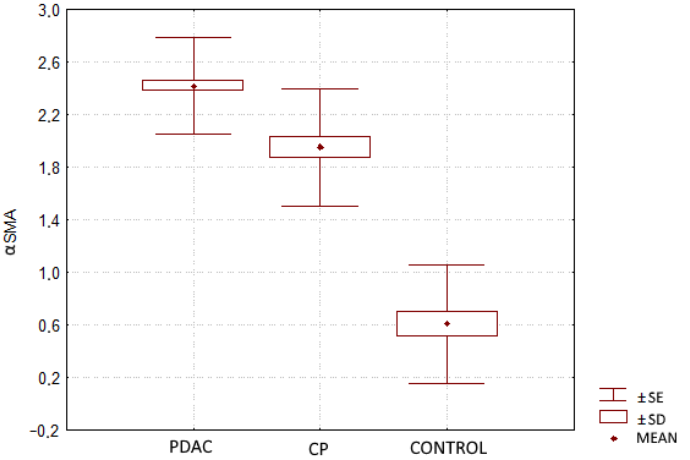
Figure 2. Comparison of α SMA expression in pancreatic ductal adenocarcinoma (PDAC), chronic pancreatitis (CP) and in healthy tissue (CONTROL).